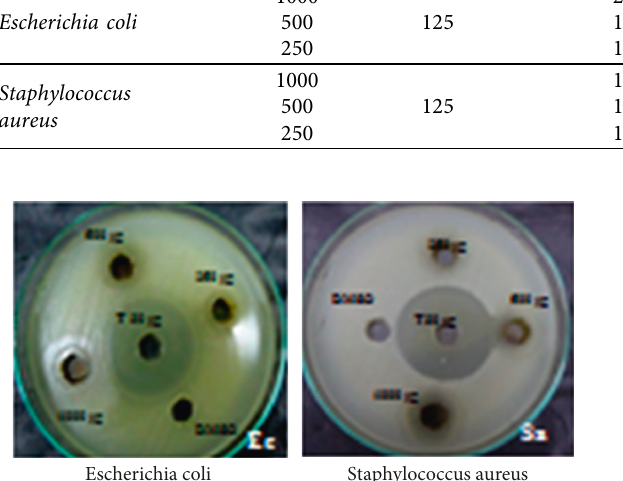
Figure 7: Antimicrobial activity of PA@AgNPs against human pathogens by well diffusion method using Escherichia Coli and Staphylococus aureus